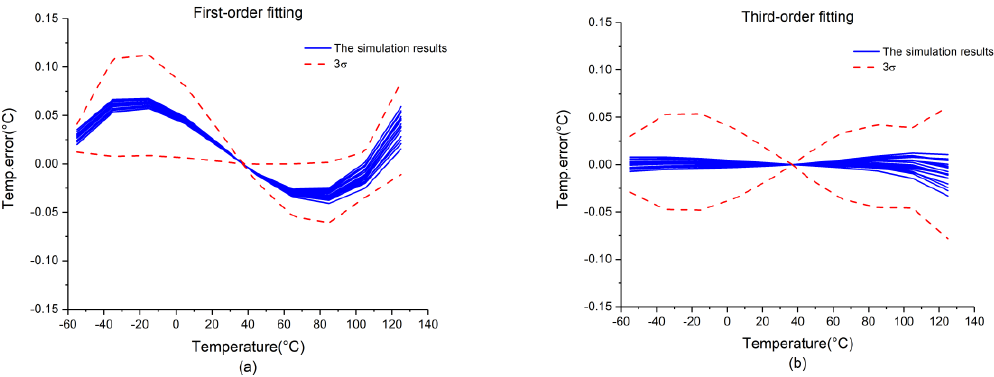
Figure 8. Simulation results of the front-end circuit: ( a ) first-order fitting; ( b ) third-order fitting.